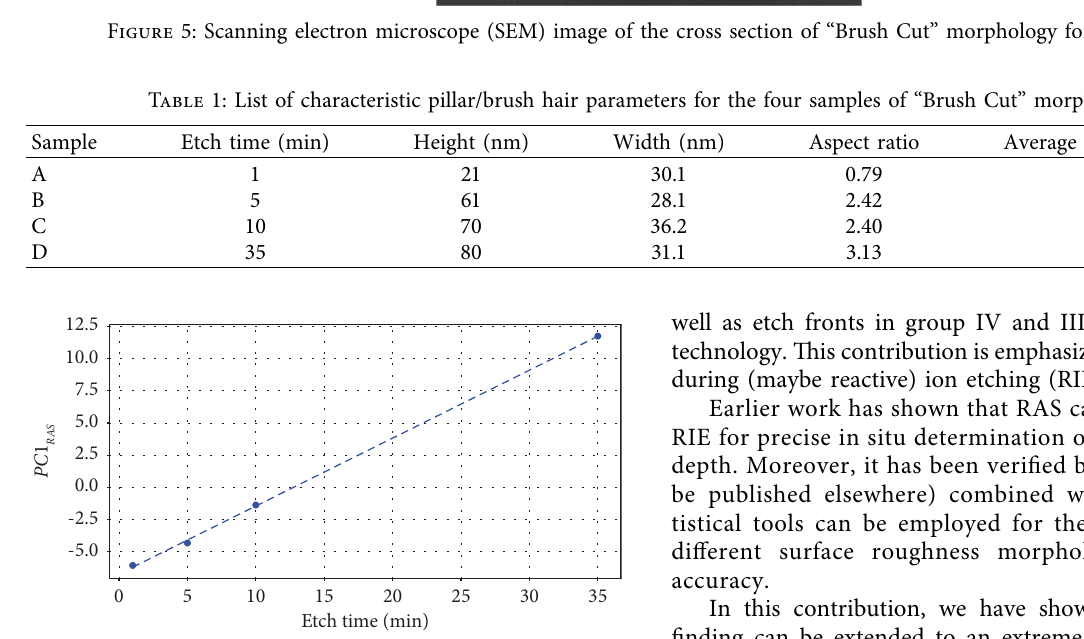
Figure 6: Dependence of PC1 nearly proportional.